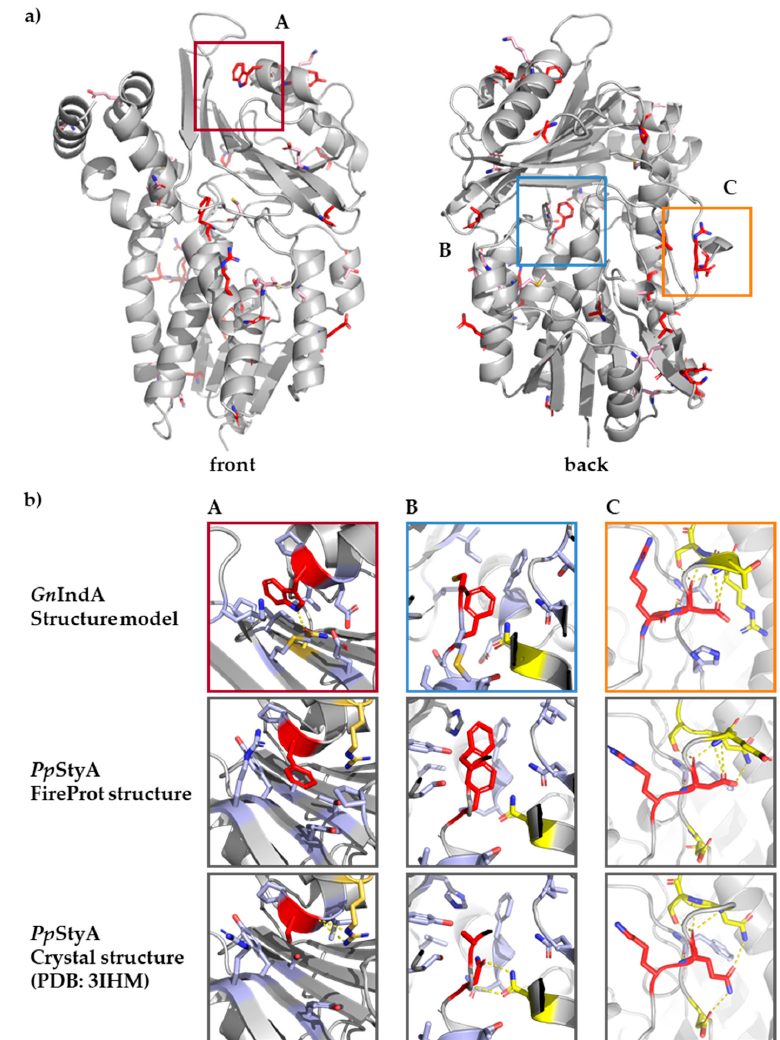
Figure 5. ( a ) structure model of Gn IndA calculated with Modeler 9.23 using the SMO structure Pp StyA from Pseudomonas putida S12 (PDB: 3IHM) as template. Amino acids targeted by the FireProt webserver on the template structure are highlighted in the Gn IndA model: red if mutated, pink if functionally different mutation. ( b ) Magnification of three structural hot spot regions of the Gn IndA structure model (top), as highlighted in ( a ), in comparison with the altered structure (middle) and the template crystal structure (bottom). Color code: red: altered amino acid, yellow: amino acid with directional interaction, blue: amino acid with non-directional interaction and surrounding amino acids. A : S249 does not cause hydrophobic interaction with the β -sheet amino acids. The S249F mutation increases the interaction between both secondary structure elements. In the Gn IndA model, W251 causes hydrophobic interactions as well but additionally rigidifies the structure by a hydrogen bond to N192 of the β -sheet below. B : In the Pp StyA structure, two helices are connected by hydrogen bonds between N51 (red) and N309 while A49 contributes little to the hydrophobic interactions in this central interaction point of three α -helices. By means of FireProt, stronger interactions are achieved by the double mutation A49F/N51F ( ΔΔ G = − 4.4 kJ mol − 1 ). The Gn IndA model already contains F50 while C48 contributes more to the hydrophobic interactions than A49 in the Pp StyA structure. C : The mutation Q155D leads to an alternative hydrogen bond network forcing a more rigid α -helical structure while the tightness of the hydration shell is strengthened due to a charge increase by the K154R mutation.